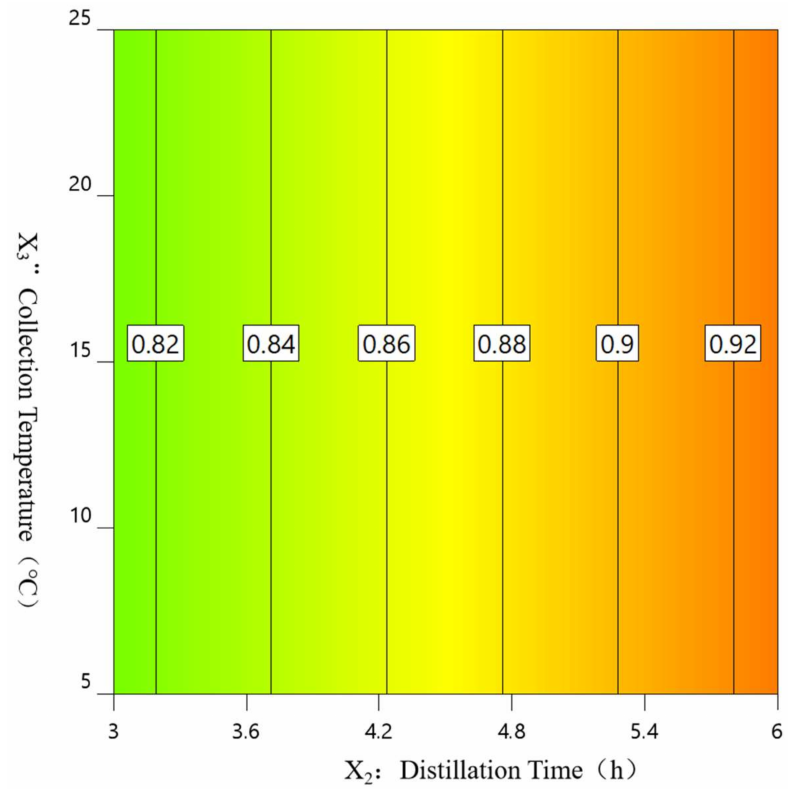
Figure 5. Volatile oil yield when the fixed water addition was 10 mL/g.